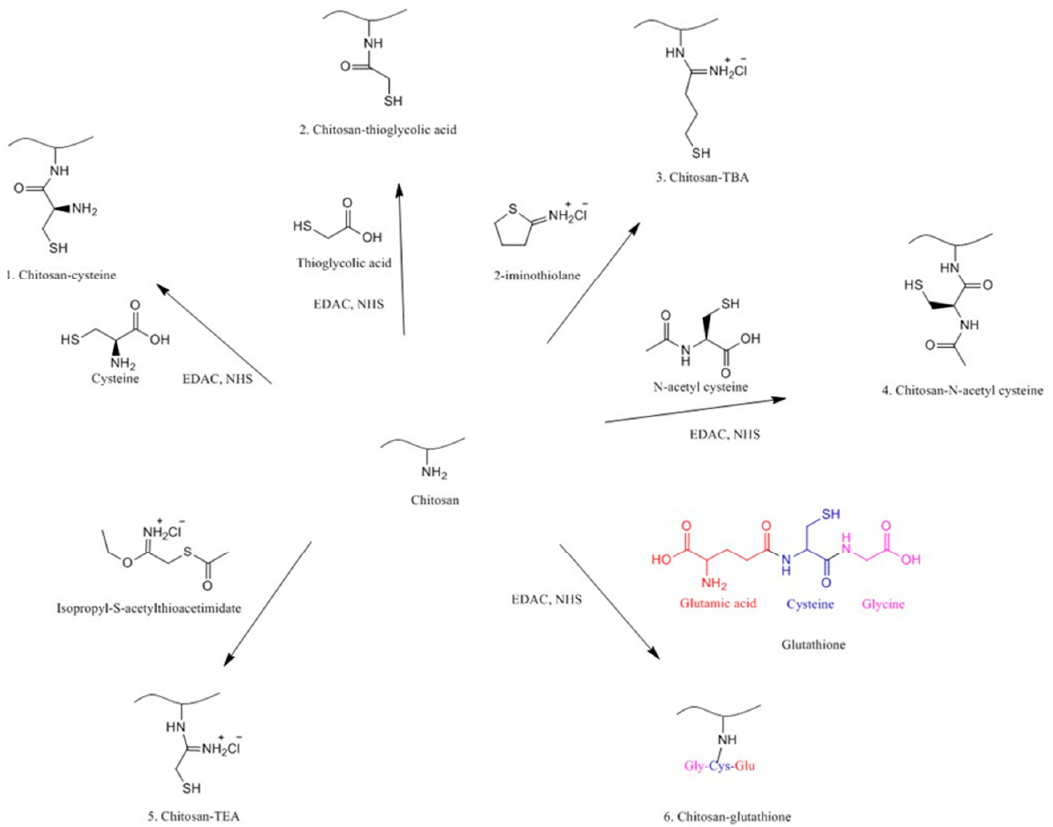
Figure 8. Synthetic pathways to different thiolated chitosan derivatives [14,84–89,91].